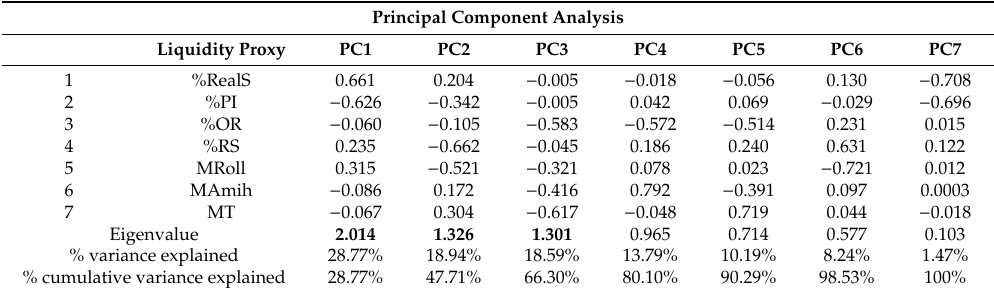
Table 4. The Principal Component Analysis (PCA) findings from the seven liquidity proxies on the Warsaw Stock Exchange (WSE) (the whole sample period).